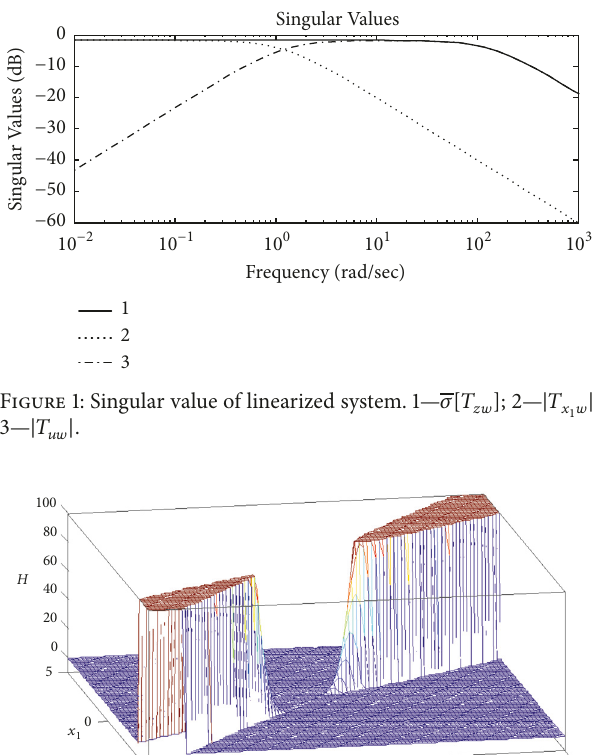
Figure 2: Hamiltonian functions of nonlinear